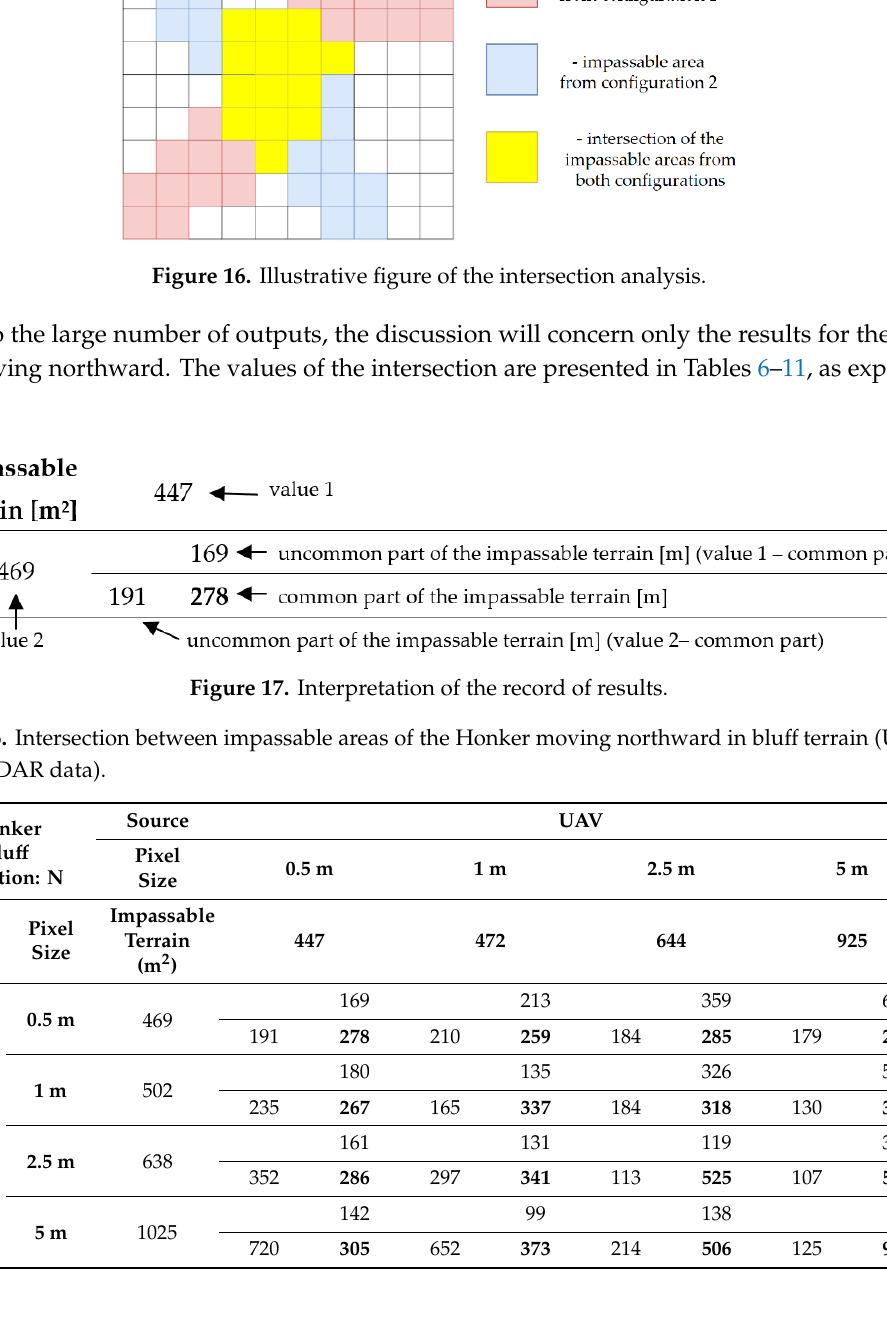
Figure 15. 3D visualization of the bluff terrain with indicated impassable areas depending on the pixel size.